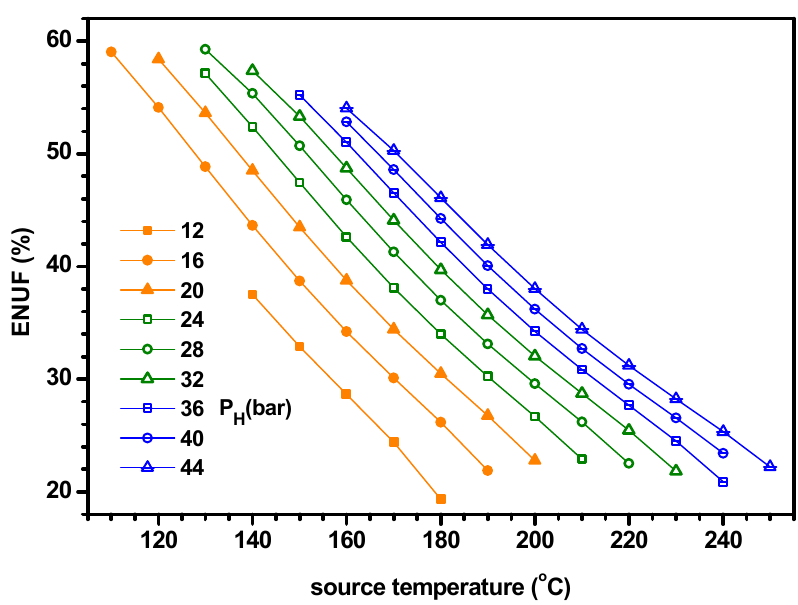
Figure 20. Effect of source temperature on the ENUF. Figure 20. E ff ect of source temperature on the